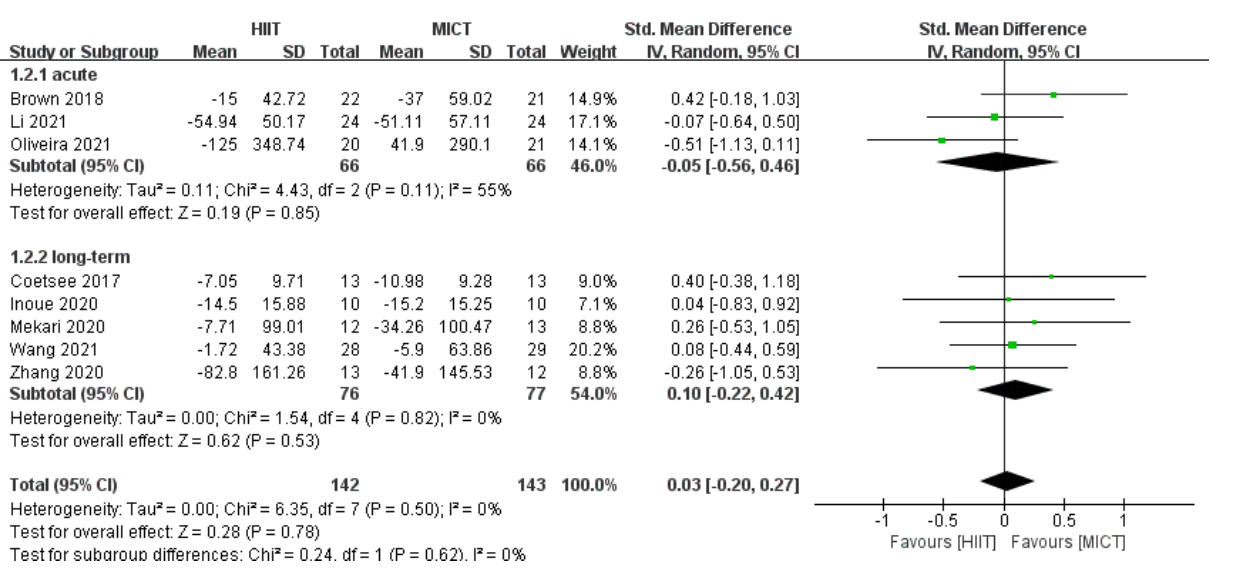
Figure 5. Subgroup analysis of HIIT and MICT on the correct rate of intervention period [24,25,34].